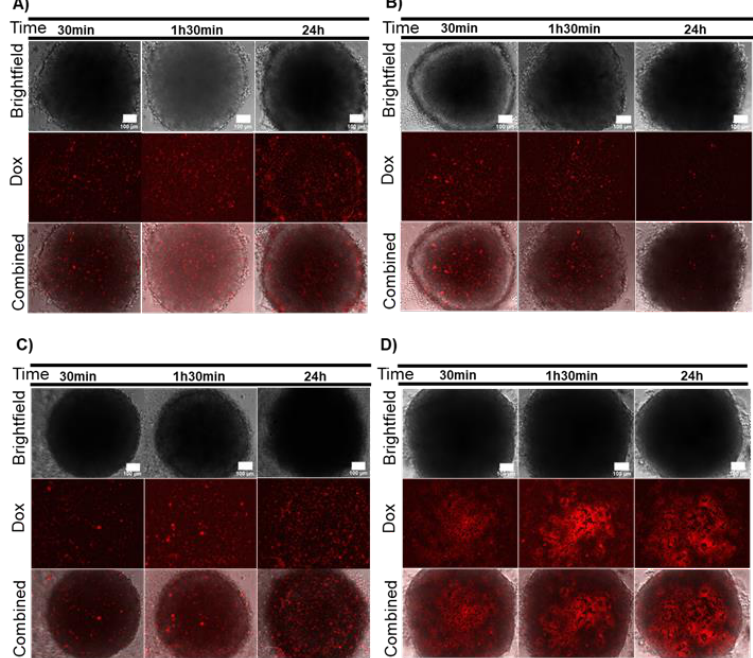
Figure 6. Effect of AuNPs and irradiation in Doxorubicin (Dox) diffusion in Dox-resistant HCT116 (HCT116-DoxR) spheroids. ( A ) HCT116-DoxR spheroids irradiated with a 532-nm laser for 1 min and then incubated with 8 μM Dox; ( B ) HCT116-DoxR spheroids incubated for 6 h with 8 μM Dox and then irradiated with a 532-nm laser for 1 min; ( C ) HCT116-DoxR spheroids incubated with 8 nM AuNP@PEG, irradiated with a 532-nm laser for 1 min and then incubated with 8 μM Dox; ( D ) HCT116-DoxR spheroids incubated with 8 nM AuNPs, incubated for 6 h with 8 μM Dox and then irradiated with a 532-nm laser for 1 min. Microscopy images were acquired in Brightfield or with a red fluorescence filter after 30 min, 1h 30 min or 24h incubation. The combined images result from the overlap between Brightfield and red filter images. Scale bar corresponds to 100 μm.